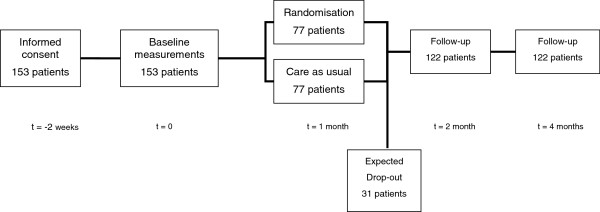
Study flow-chart.